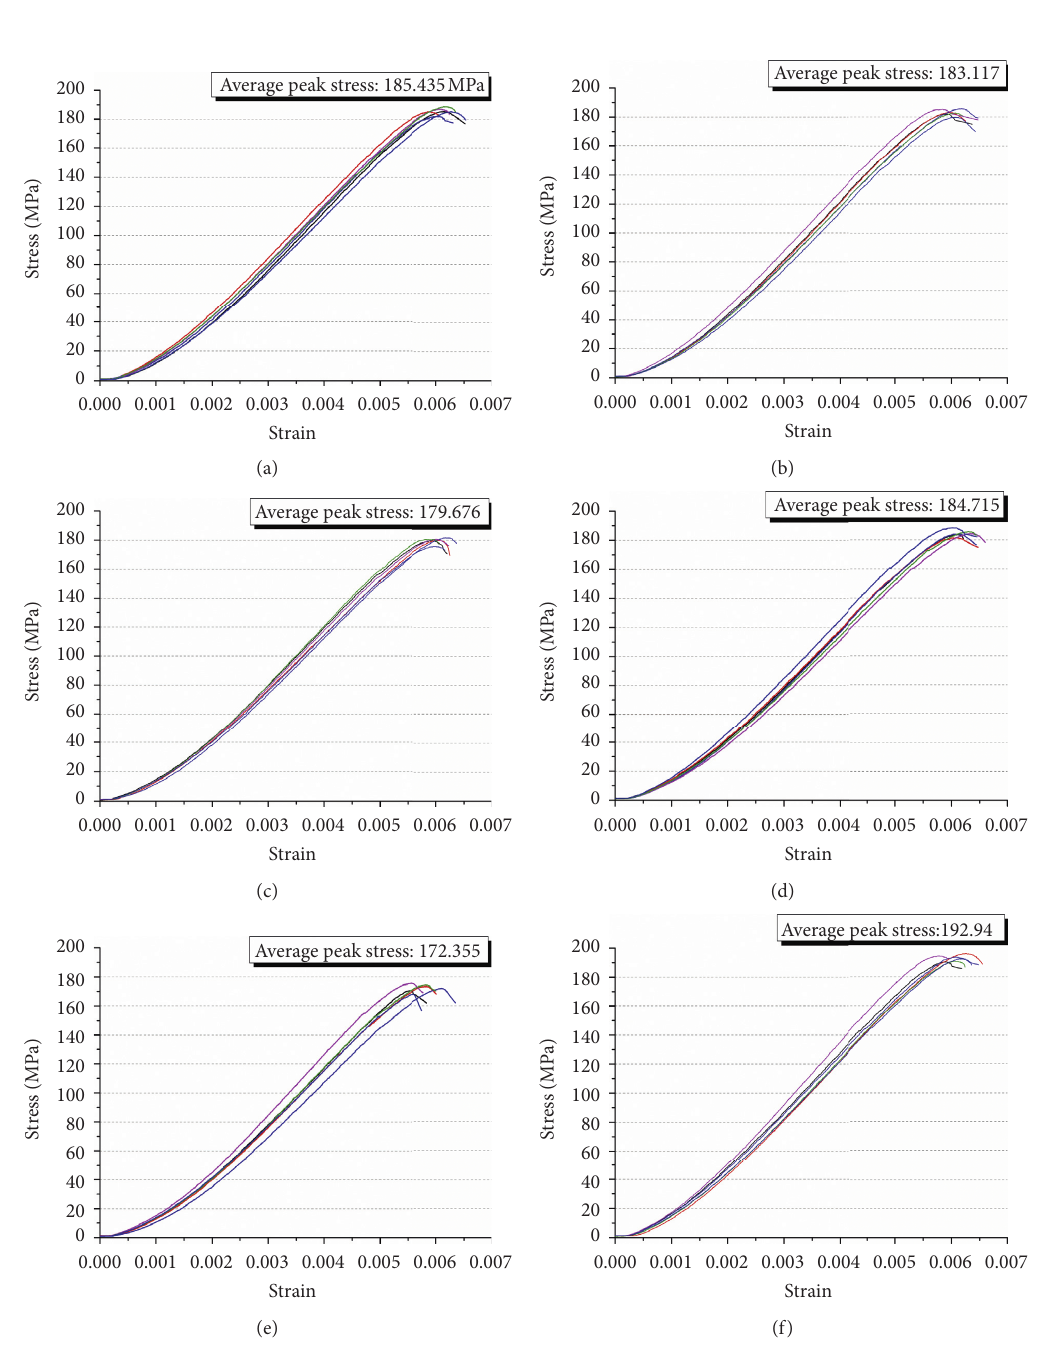
Figure 10: Stress-strain curves for each rock specimen group: (a) group A; (b) group B; (c) group C; (d) group D; (e) group E; and (f) group